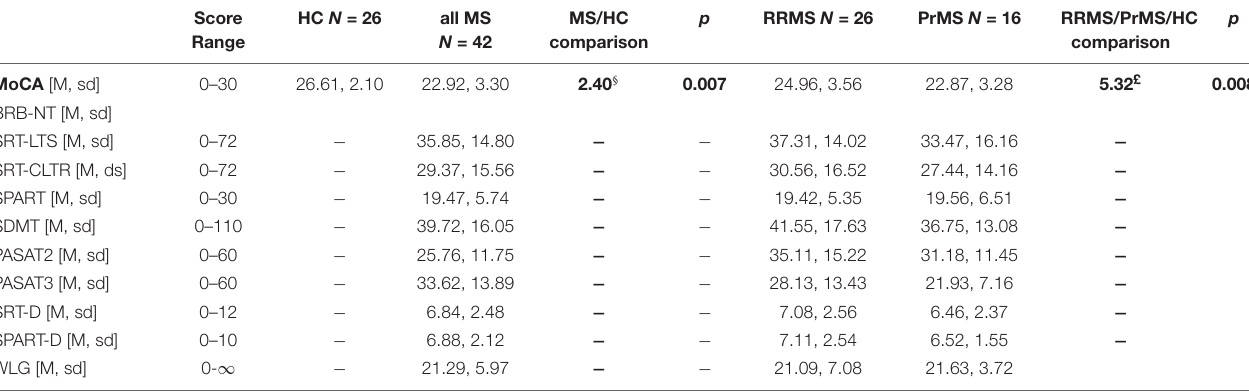
TABLE 2 | Neuropsychological test and group comparison